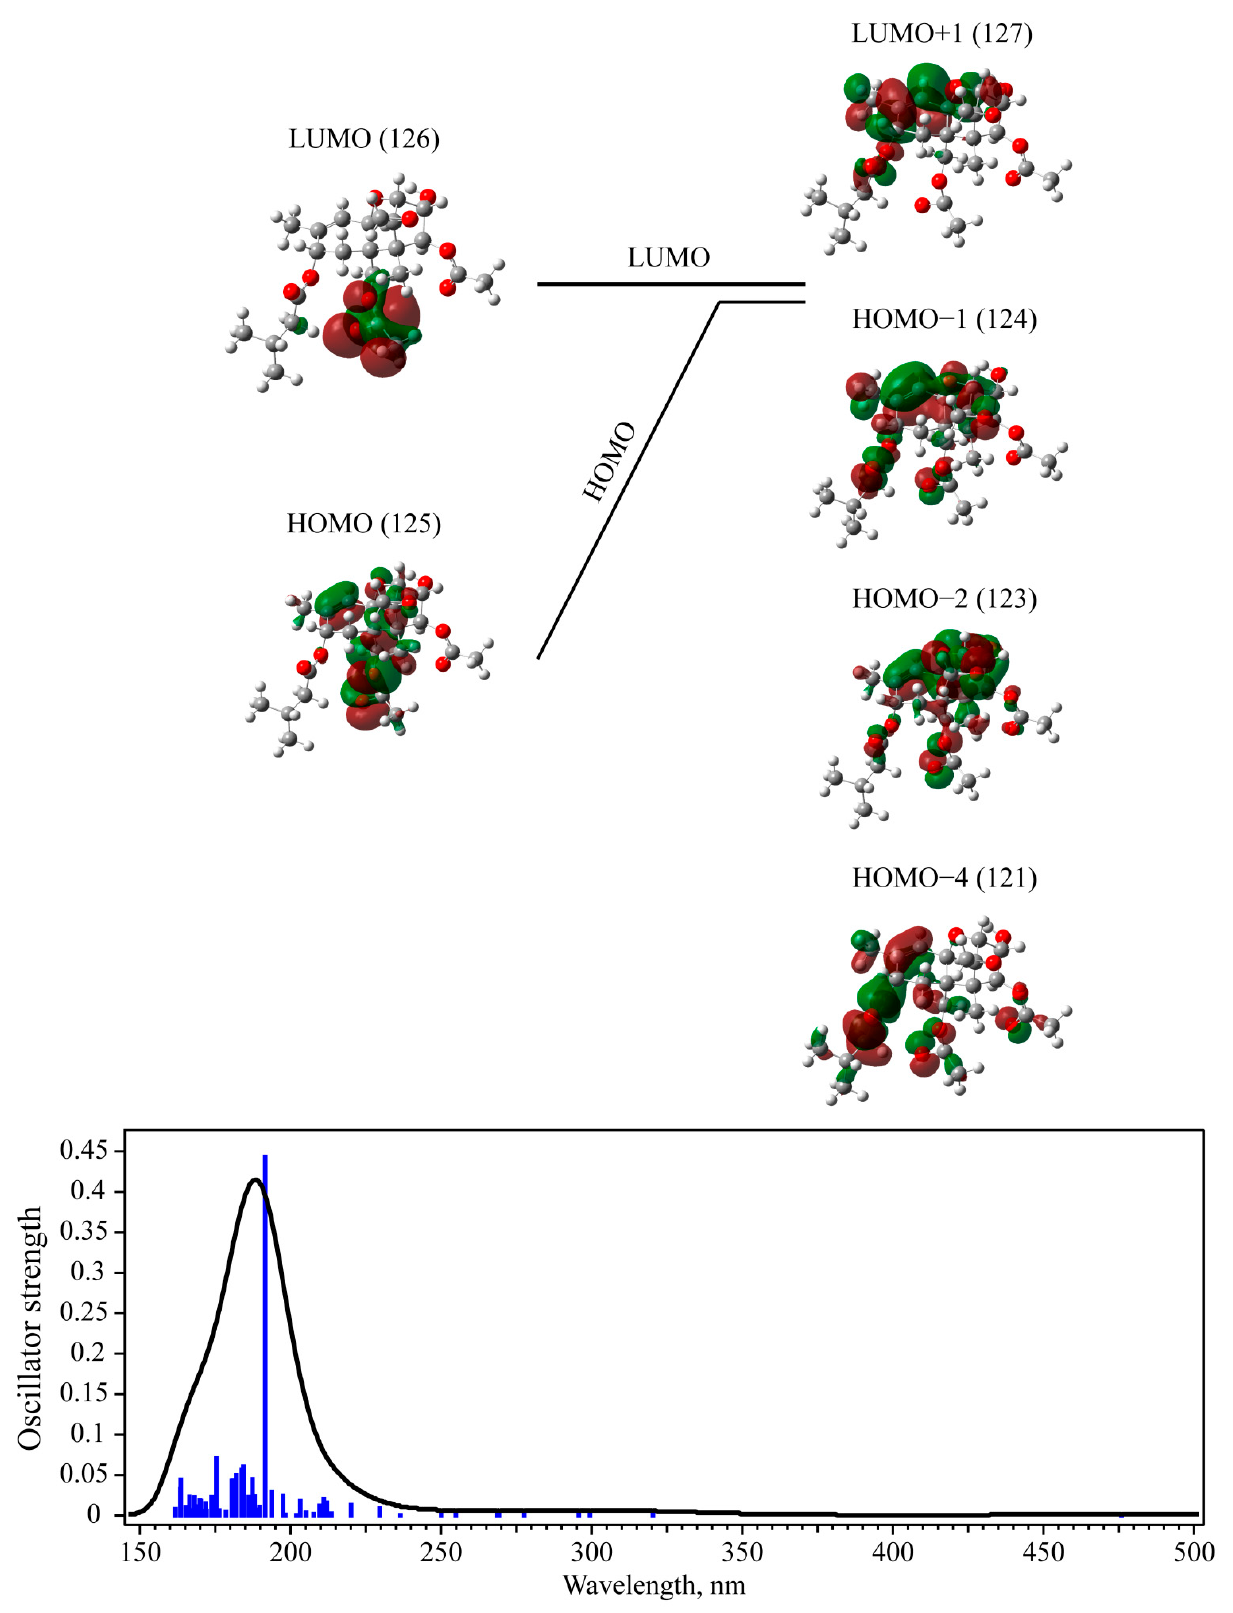
Figure 8. TD-DFT calculated selected molecular orbitals for T-2 toxin in methanol ( top ) and calculated UV-Vis absorbance spectra ( bottom ).